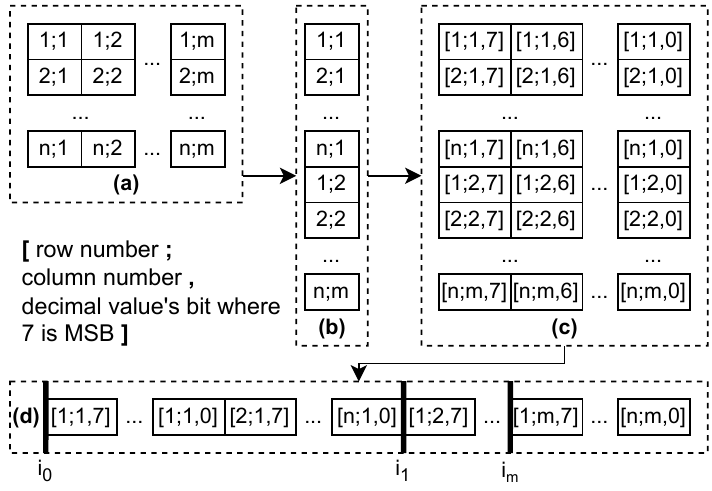
Figure A1. Creation of data bits from the image where n is image pixel row length, m is image pixel column length, and i is frame or image column number. ( a ) Image matrix with decimal values. ( b ) Image matrix reshaped into column vector with decimal values. ( c ) Matrix of each image pixel (matrix row) and its binary value in matrix columns. ( d ) Data row containing the image in bits where black lines show a start of an image pixel